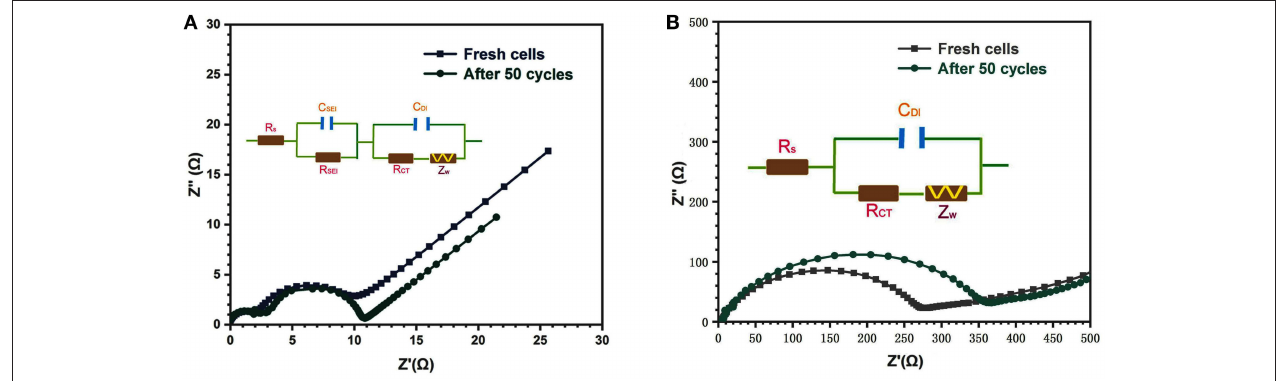
FIGURE 7 | Impedance analysis of CC/SnO 2 nanotube arrays (A) and SnO 2 nanoparticles (B) .